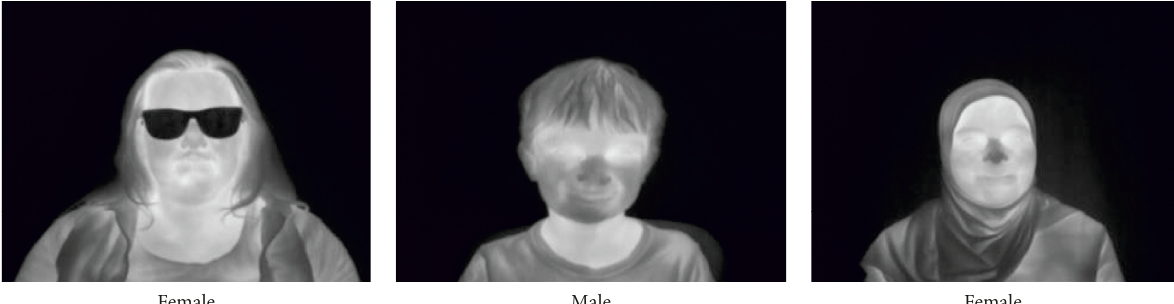
Figure 9: Samples of IRT_ResNet classification